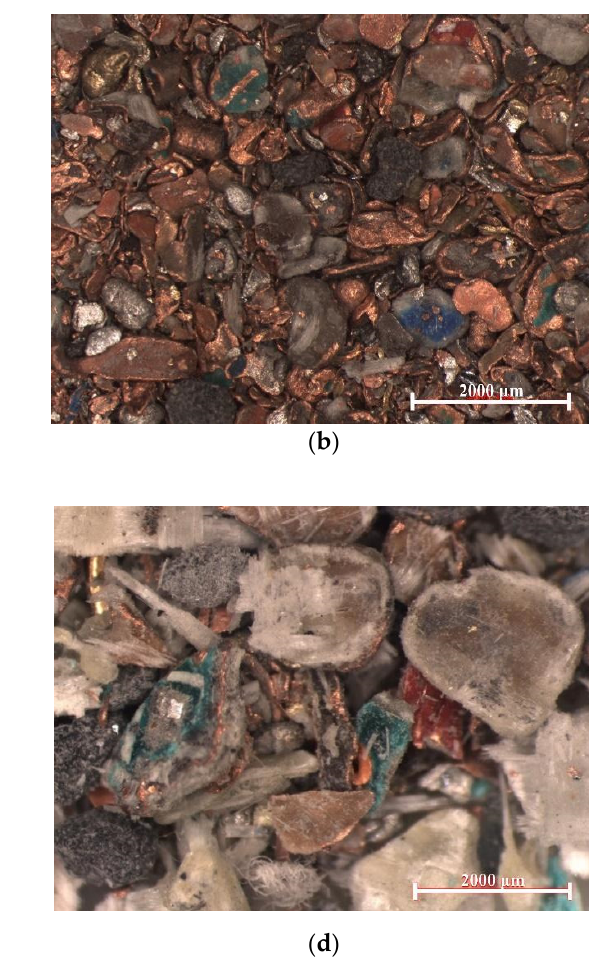
Figure 3. Intermediate from electrostatic separation (stereo microscope): ( a ) option 1, ( b ) option 2, ( c ) option 3, and ( d ) option 4.